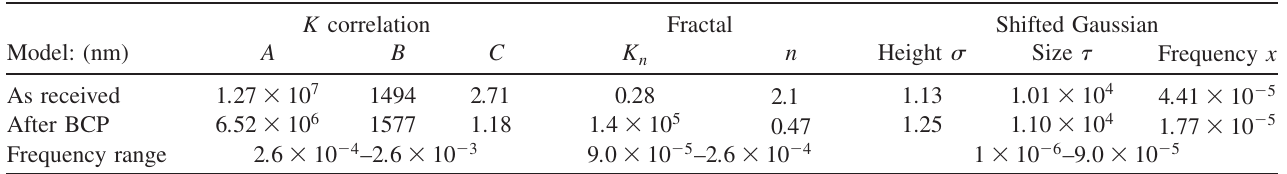
TABLE II. Fitting parameters of samples (unit: nm) for Fig. 11. K correlation